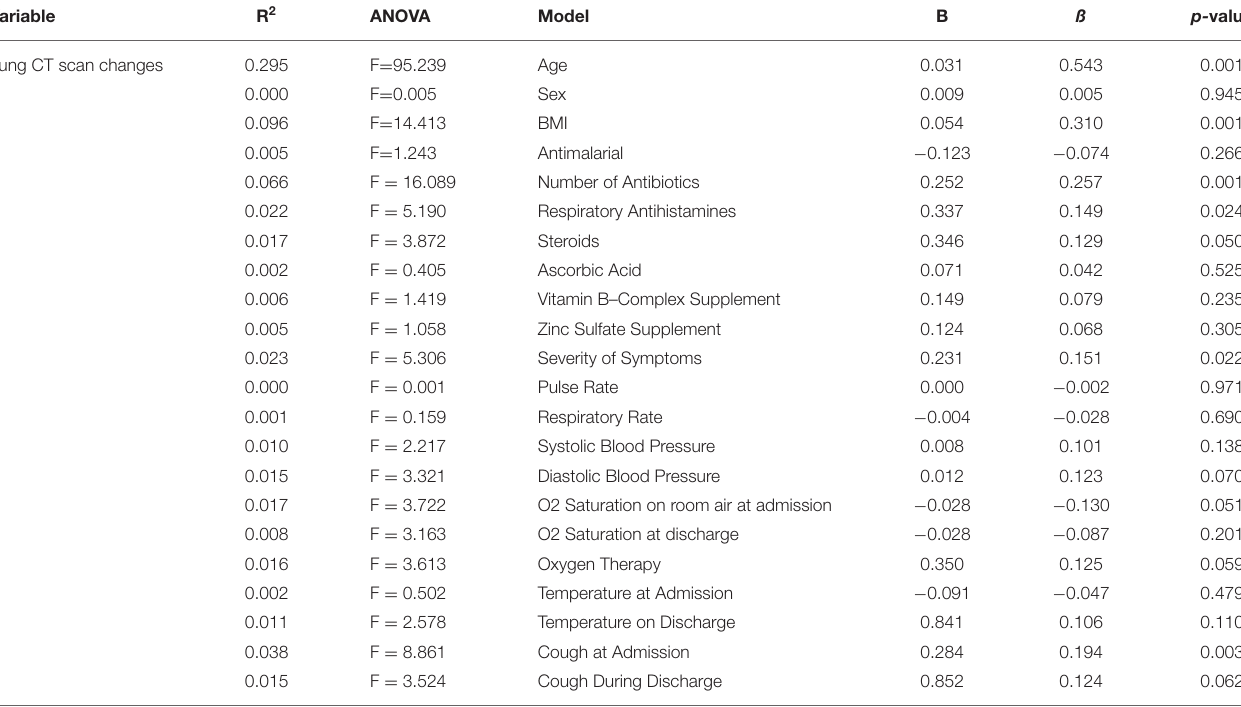
TABLE 3 | Predictors of lung CT changes among the study participants. Variable R 2 Lung CT scan